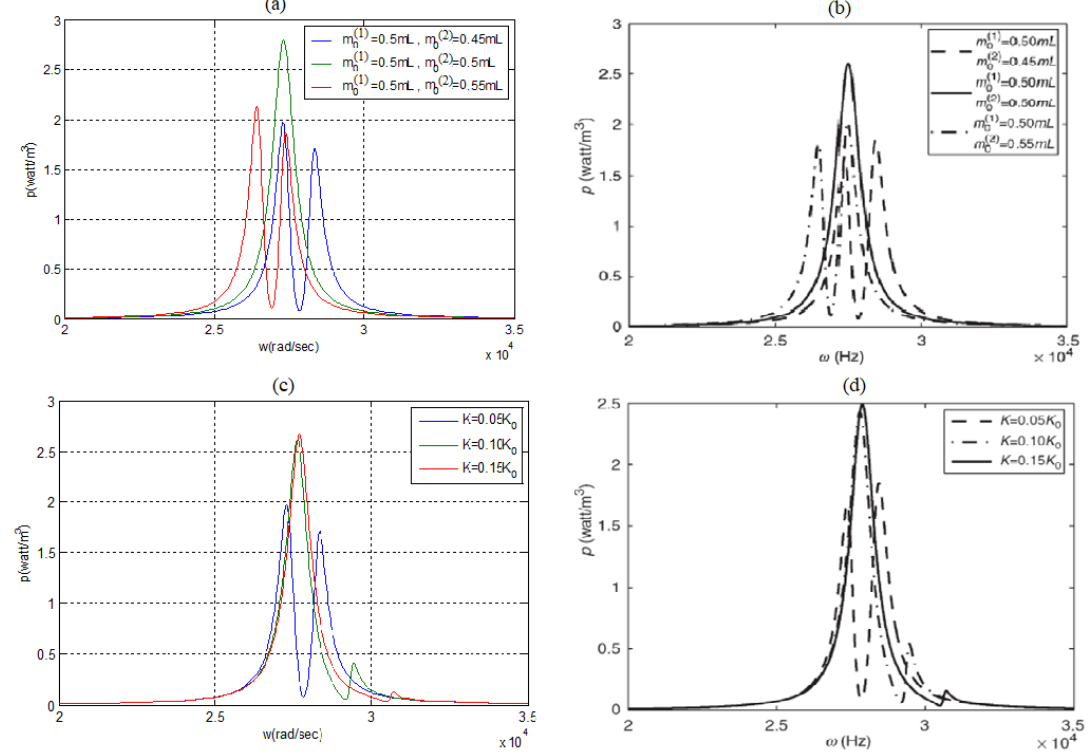
Figure 4. Two bimorphs interconnected by a spring ‐ analytic power density model results for various end masses: ( a ) present model, ( b ) from [24]; for various spring constants: ( c ) present model, ( d ) from [24].